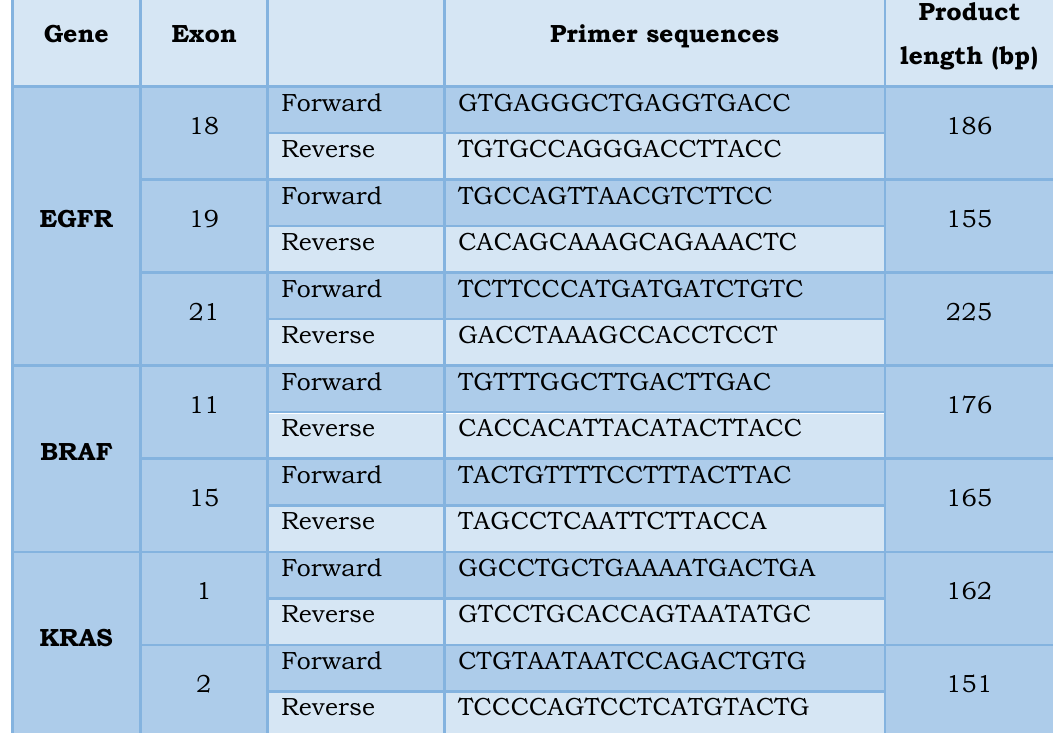
Table 1. PCR primers and product lengths of EGFR, BARF and KRAS Gene Exon Primer sequences